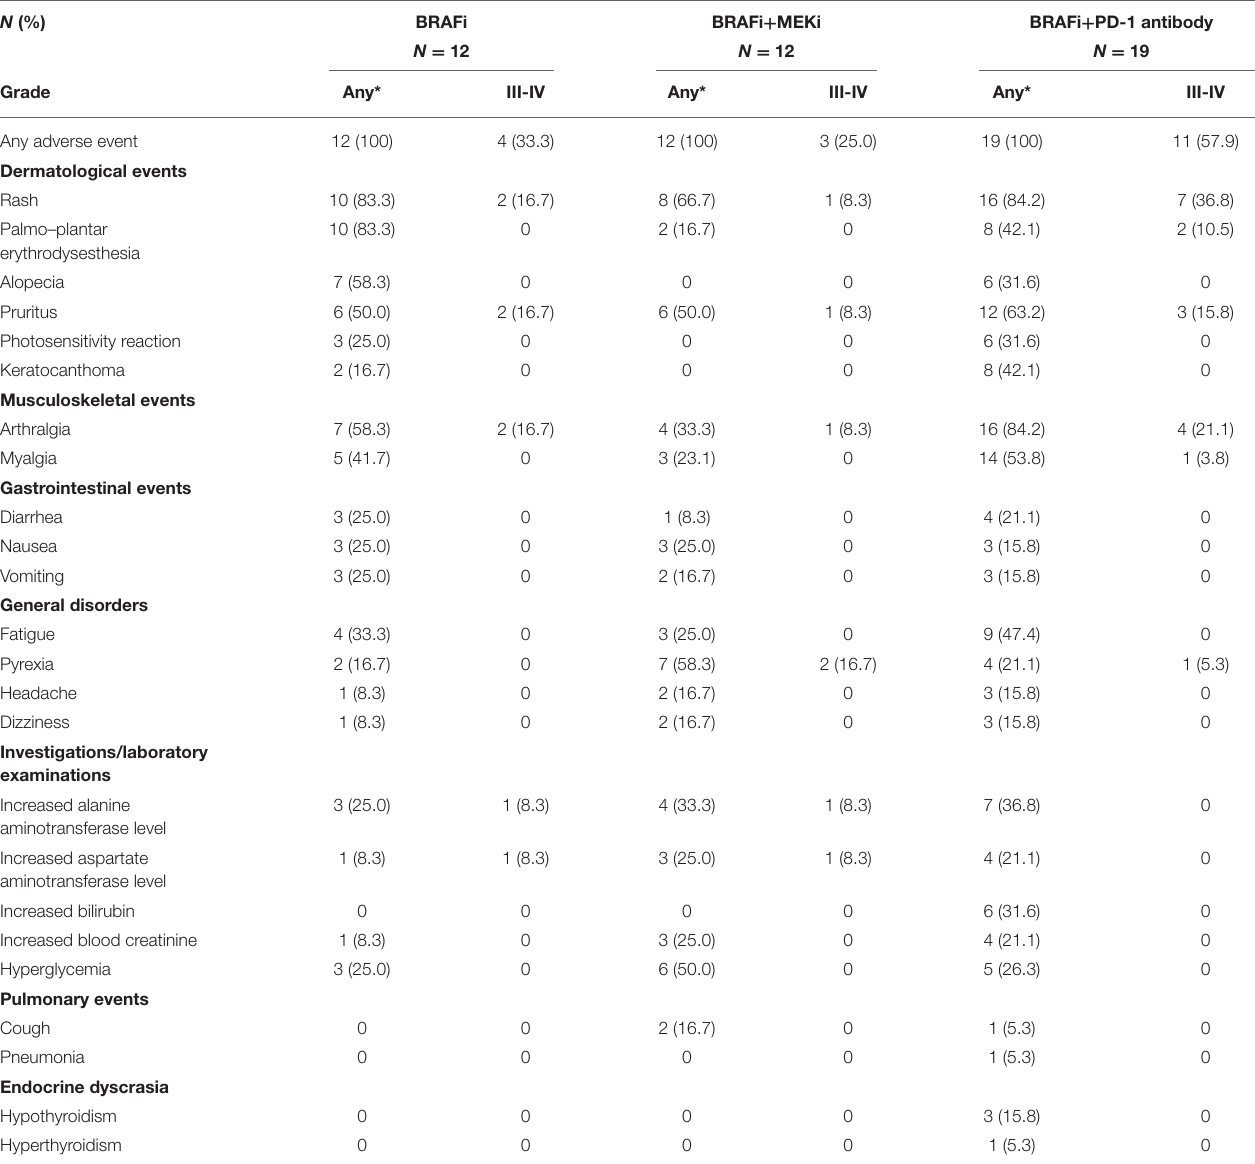
TABLE 2 | Adverse events of three regimes. N (%)